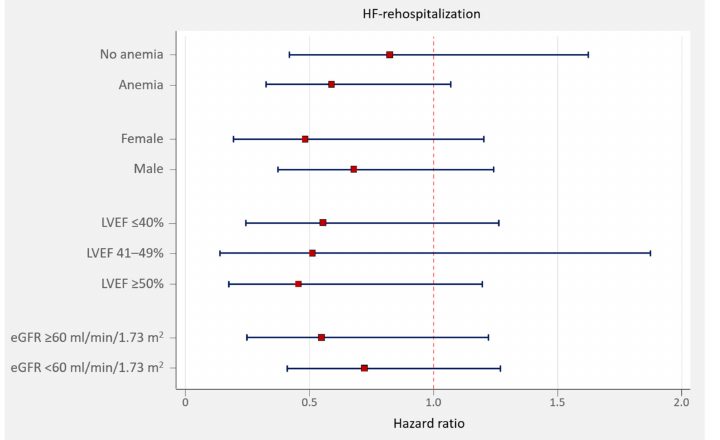
Figure 3. Subgroup analysis. Units for eGFR values are mL/min/1.73 m 2 . Error bars represent 95% confidence intervals. eGFR: estimated glomerular filtration rate; HF: heart failure; LVEF: left ventricle ejection